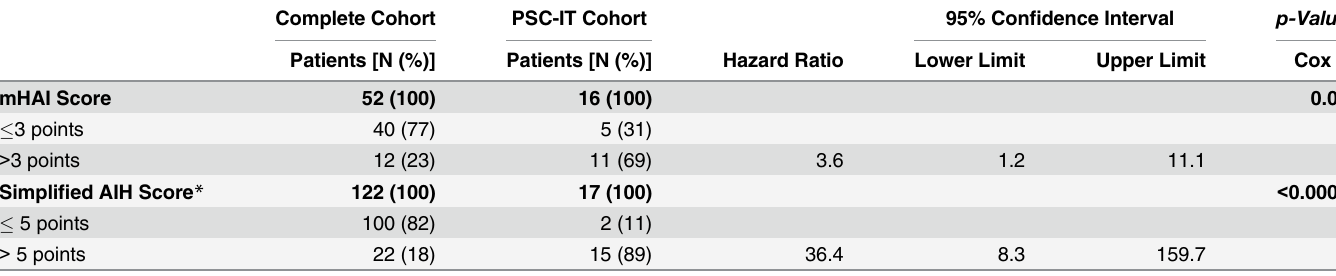
Table 3. Histological disease activity and simplified AIH score as single risk factors for IT in patients with